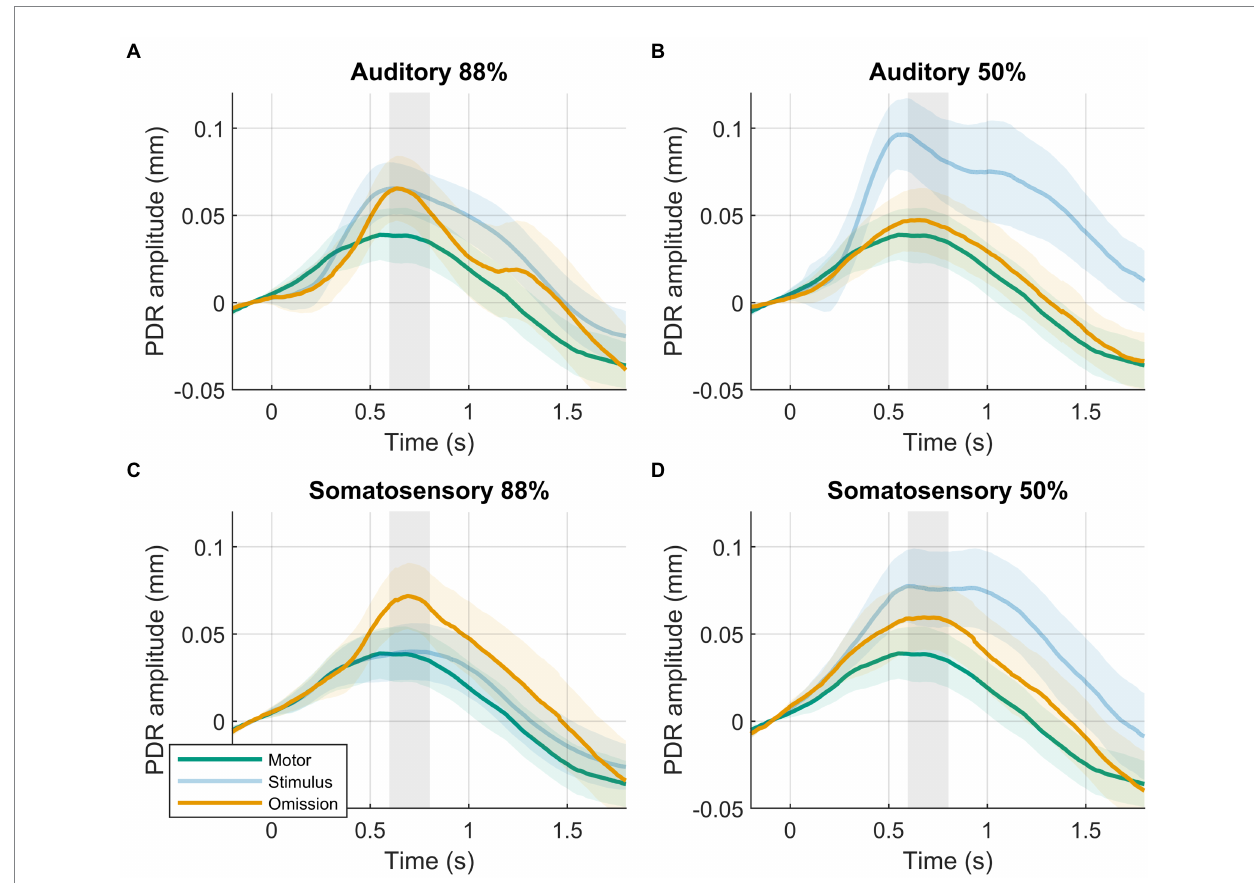
FIGURE 2 Results of planned analysis. PDRs +95% confidence intervals of motor-control (green), stimulus (blue, transparent) and omission (orange) trials. (A) Auditory 88%-condition. (B) auditory 50%-condition. (C) Somatosensory 88%-condition. (D) Somatosensory 50%-condition. Time-window for statistical analysis shown in